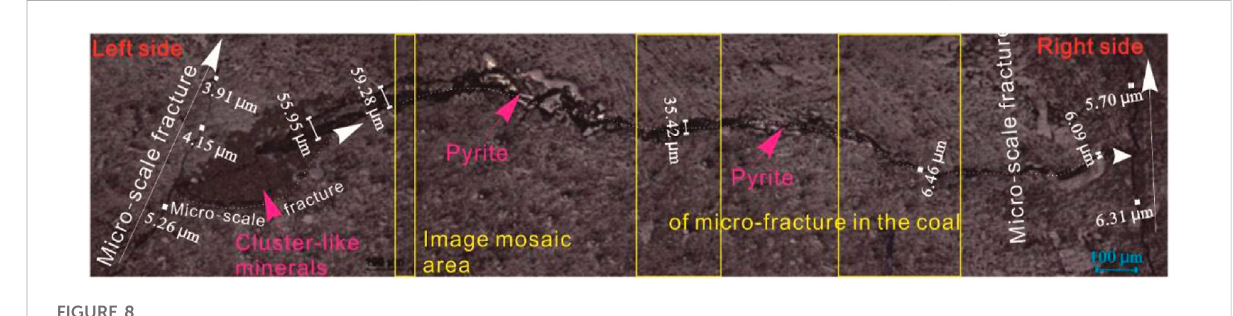
FIGURE 8 Propagation mode of micro-fracture in the